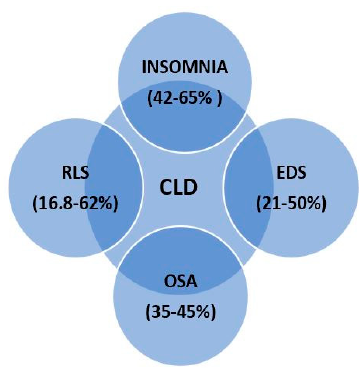
Figure 2. The most frequent phenotypes of SDs in chronic liver disease (CLD) and their preva- lence. Legend: EDS—excessive daytime sleepiness; OSA—obstructive sleep apnea; RLS—restless leg syndrome.